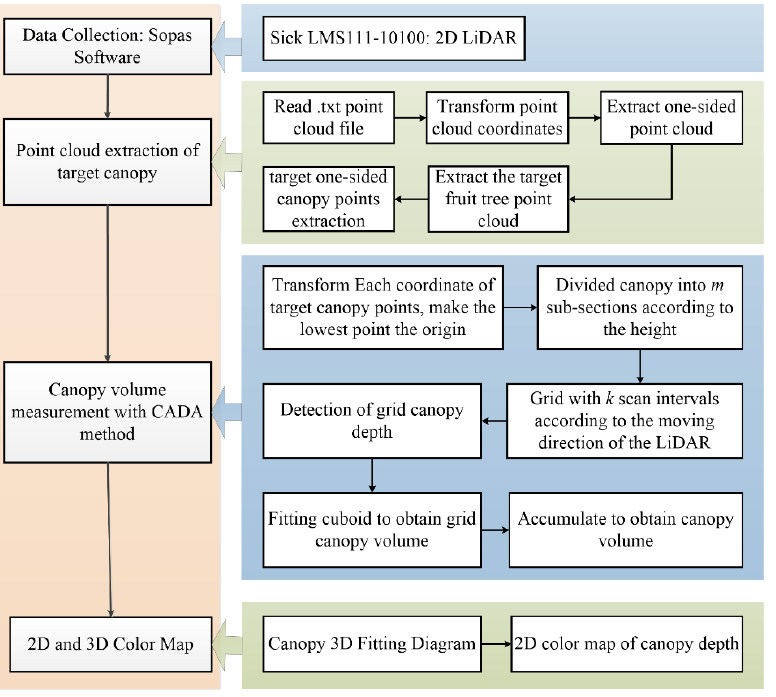
Figure 4. LiDAR point cloud processing flow.